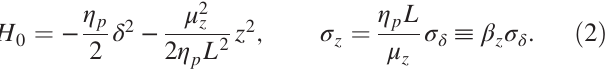
ð z Þ . The green line is the FIG. 1. Each term of the potential V PW potential generated by rf cavity ð rf Þ , the blue is wake potential ð W Þ , and the red is the total potential ð rf þ Wz Þ , where z ¼ 7 . 35 mm, σ ¼ 1 . 055 × 10 − 3 σ δ z